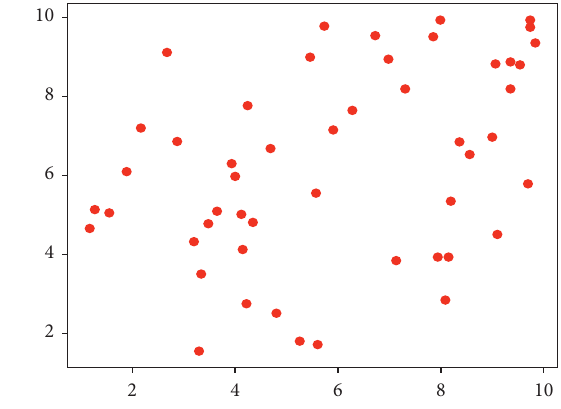
Figure 7: 50 random points graph of zone (1, 10).